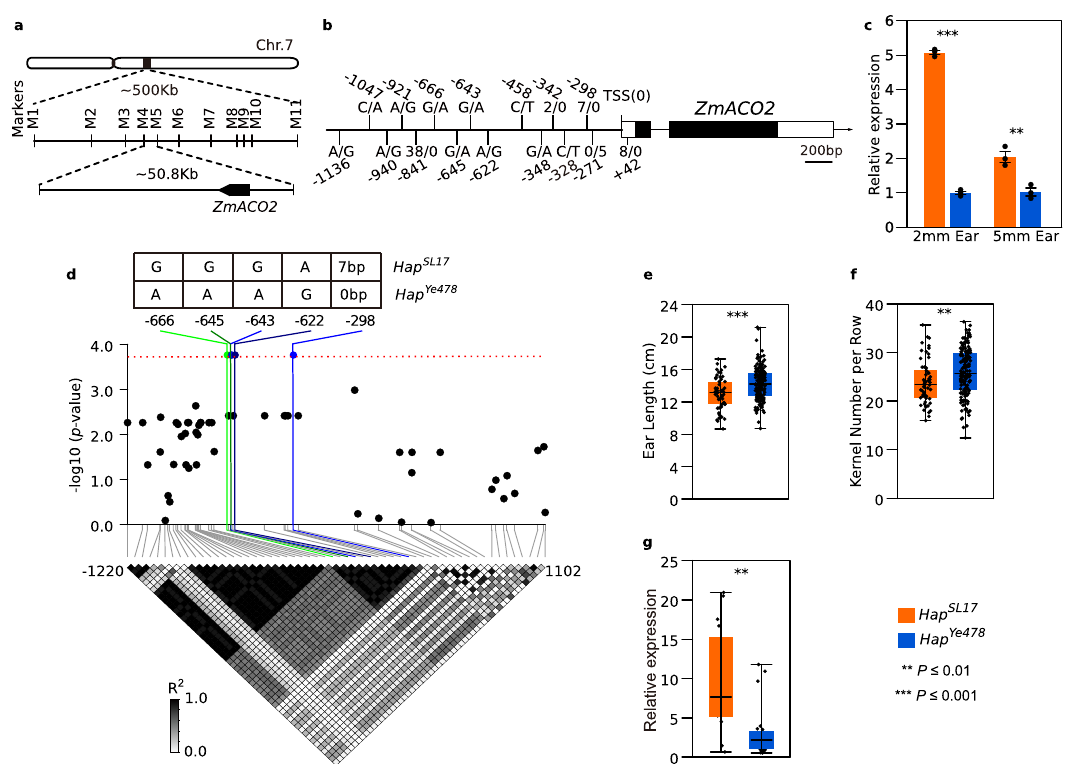
Fig. 2 ZmACO2 is the candidate gene of qEL7 and negatively affects yield-related traits. a By fi ne mapping, qEL7 was delineated into a 50.8 kb interval with only one predicted gene ZmACO2 ; detailed information is presented in Supplementary Fig. 1d. b Sequence variations identi fi ed in ZmACO2 genomic regions between NILs; the positions (relative to transcript start site, TSS) were listed beside genotypes information; the genotypes were presented as qEL7 SL17 / qEL7 Ye478 ; the nucleotide bases and numbers represent the genotypes of SNPs and base pairs of InDels, respectively; white box, UTR region; black box, exon; arrowhead, gene direction. c ZmACO2 expression was lower in the 2 mm ( p = 4.33 × 10 − 7 ) and 5 mm ( p = 0.0034) ears of qEL7 Ye478 (blue bar) than that in qEL7 SL17 (orange bar), data are presented as means ± SD and ** p -value ≤ 0.01, *** p -value ≤ 0.001, from a two-tailed, two-sample t-test. d Five variants in ZmACO2 promoter show association with ear length in diversity inbred lines; the red dash line indicates the threshold of signi fi cant association at p ≤ 1.79 × 10 ‒ 4 ; the white to black heatmap shows the pairwise linkage disequilibrium pattern by R 2 ; the genotypes and positions (relative to TSS) of fi ve signi fi cant association loci are shown on the top and indicated by green and blue dash lines. Hap Ye478 haplotype has a longer ear ( e , p = 6.94× 10 − 5 ), more kernel number per row ( f , p = 0.0041) and lower ZmACO2 expression ( g , p = 0.0014, H = 10.26) than Hap SL17 haplotype among diverse inbred lines; orange box, Hap SL17 haplotype ( n = 56 in e and f , n = 16 in g ); blue box, Hap Ye478 haplotype ( n = 158 in e and f , n = 24 in g ); each box represents the median and interquartile range, and whiskers extend to maximum and minimum values; ** p -value ≤ 0.01, *** p -value ≤ 0.001 from a two-tailed, two-sample t-test ( e , f ) and Kruskal – Wallis test ( g ). For expression level is measured by qRT-PCR; three biological replicates and three technical replicates in ( c ); one biological replicate and three technical replicates for each line in ( g ); approximately 20 ears were used in each biological replicate. n is the number of inbred lines examined in ( e − g